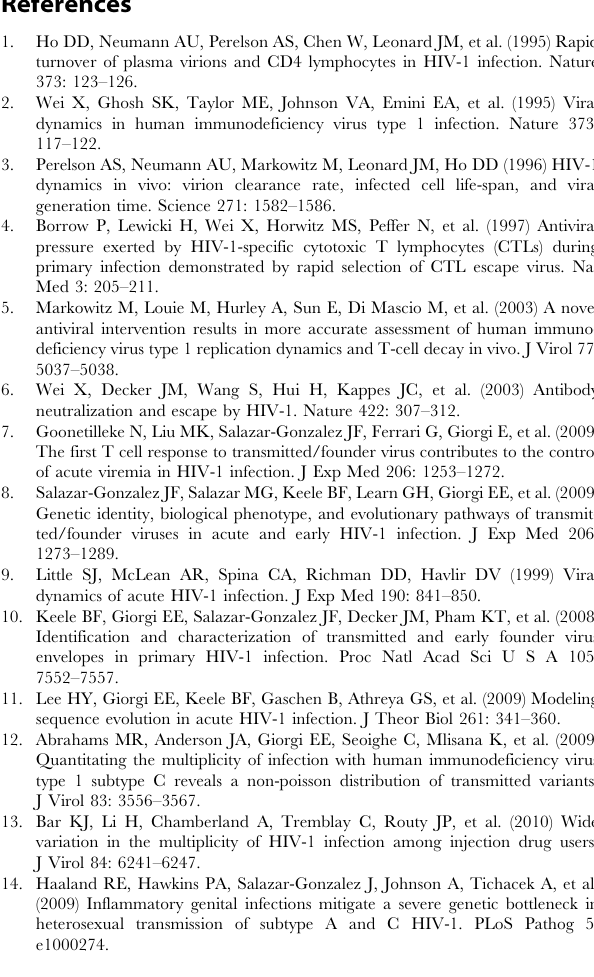
Table S1 Frequency (%) of CH40 V1 Nab epitope sequence variants measured by SGA and PASS. Table S2 Frequency (%) of CH77 V2 Nab epitope sequence variants measured by SGA and